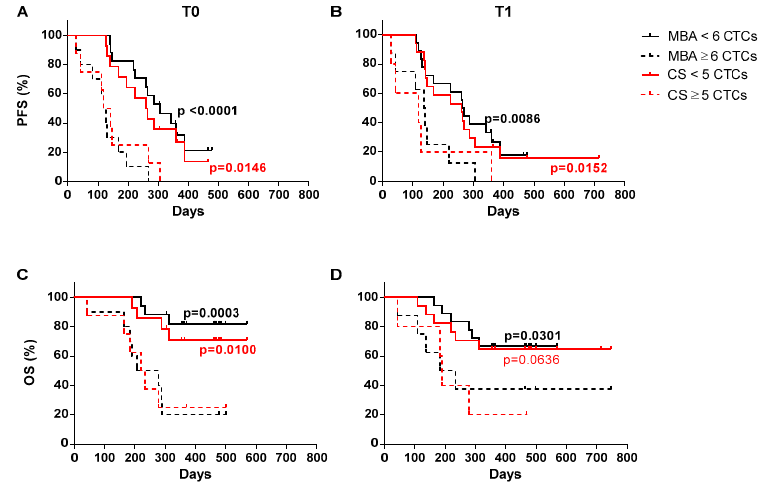
Figure 4. Progression-free survival (PFS) and overall survival (OS) of mBC patients. ( A ) Kaplan-Meier plots estimating PFS at baseline (T0) and ( B ) first follow-up (T1) by the metabolic-based assay (MBA) and the CellSearch (CS) method. ( C ) Kaplan-Meier plots estimating OS at baseline (T0) and ( D ) first follow-up (T1) by the MBA and the CS method. For these analyses, mBC patients were stratified using a cut-o ff value of 6 CTCs for the MBA and 5 CTCs for the